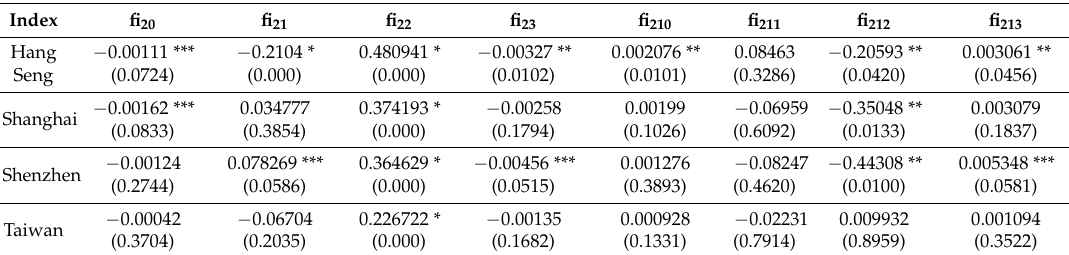
Table 5. Market Model